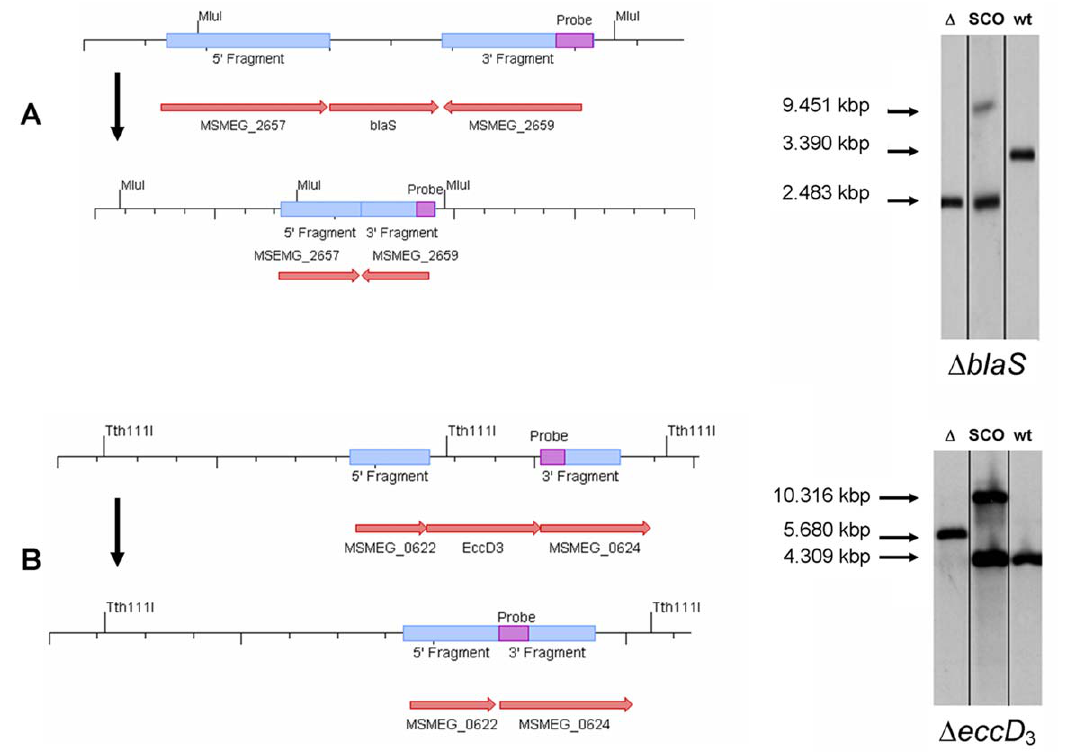
Figure 2. Strategy for targeted generation of mutants and Southern blot analysis. (A) Schematic drawing of the blaS ( MSMEG_2658 ) genomic region of the wild-type and the knock out strain (not drawn to scale). Southern blot analysis confirms the deletion of blaS from the genome of M. smegmatis . Genomic DNA of M. smegmatis was digested with restriction endonuclease Mlu I. A DIG labeled PCR fragment from one of the flanking regions was used as a probe. The wild-type band (wt) was calculated to be 3.39 kbp. The 3 9 single cross over (sco) bands correspond to lengths of 9.451 kbp and 2.483 kbp, respectively. The knock out strain ( D ) corresponds to a length of 2.483 kbp. (B) Schematic drawing of the eccD 3 ( MSMEG_0623 ) genomic region of the wild-type and the knock out strain (not drawn to scale). Southern blot analysis confirms the deletion of eccD 3 from the genome of M. smegmatis D blaS . Genomic DNA was digested with restriction endonuclease Tth 111I. The wild-type band (wt) was calculated to be 4.309 kbp. The 5 9 single cross over (sco) bands correspond to lengths of 10.316 kbp and 4.309 kbp, respectively. The knock out strain ( D ) corresponds to a length of 5.680 kbp.